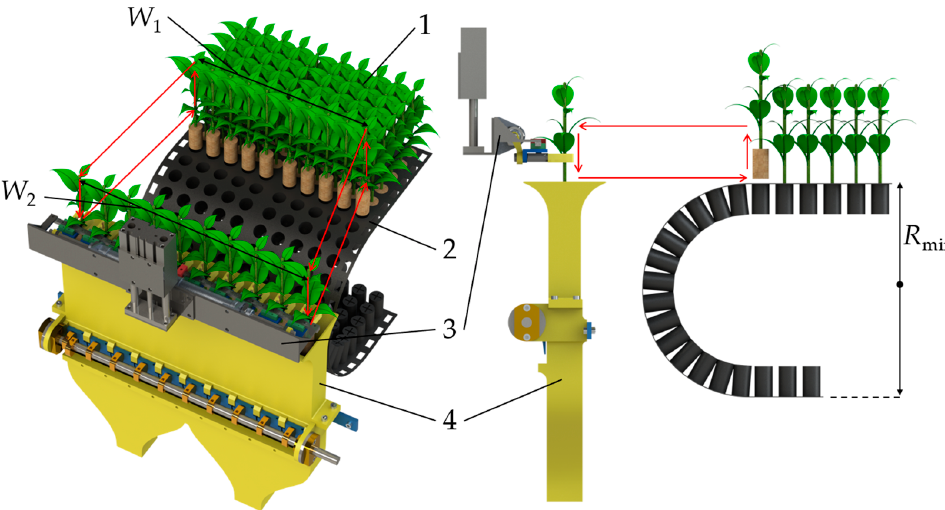
Figure 3. Principle of whole ‐ row extraction and transportation of pot seedlings: (1) seedling pot to be taken, (2) Amico D220P vegetable tray, (3) pneumatic whole ‐ row seedling launching and picking mechanism, (4) interval seedling dropping device.